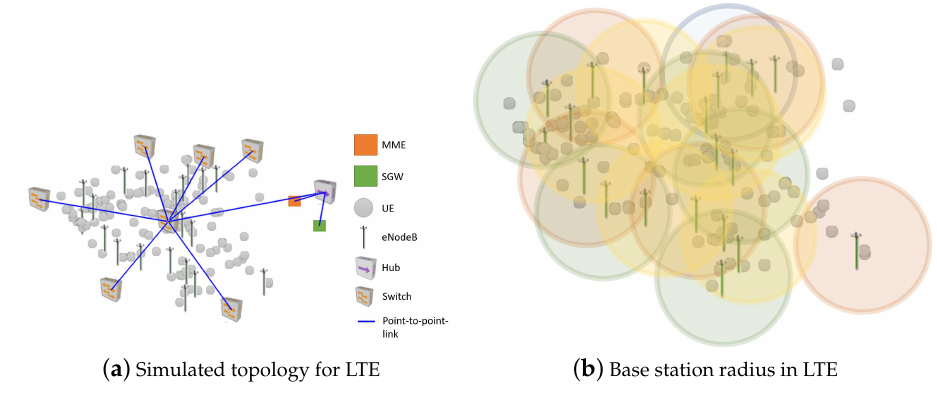
Figure 4. Topology of LTE in EXata. Table 4. Configuration of LTE and CDMA450 of base stations and user equipment.